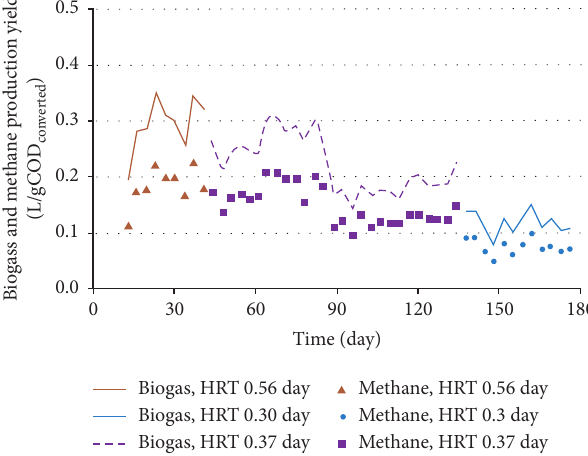
Figure 2: pH variation during operation of the MBBR system ( n � 3).